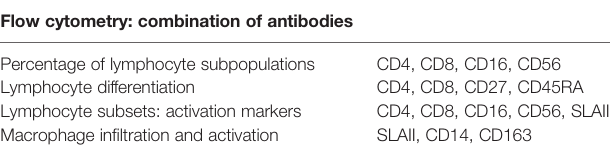
TABLE 3 | Combination of antibodies used for phenotypic analysis by fl ow cytometry of the in fi ltrated cells inside the surgical mesh. Flow cytometry: combination of antibodies Percentage of lymphocyte